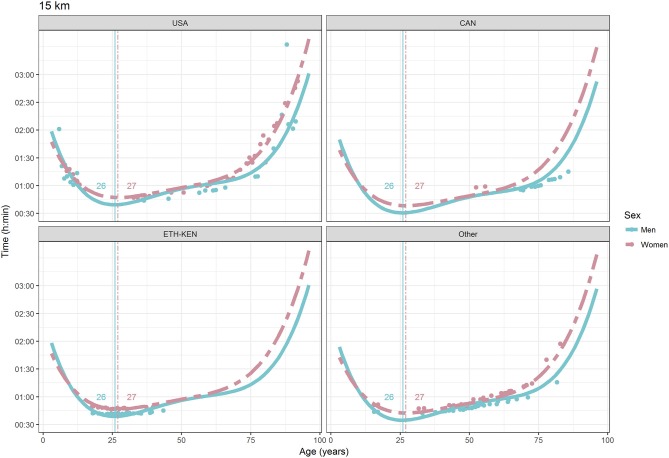
World record in 15 km by sex, age (in years), and country. Points were observations. Curves represented quartic degree polynomial regression. Vertical lines with numeric labels were the ages at peak performance.